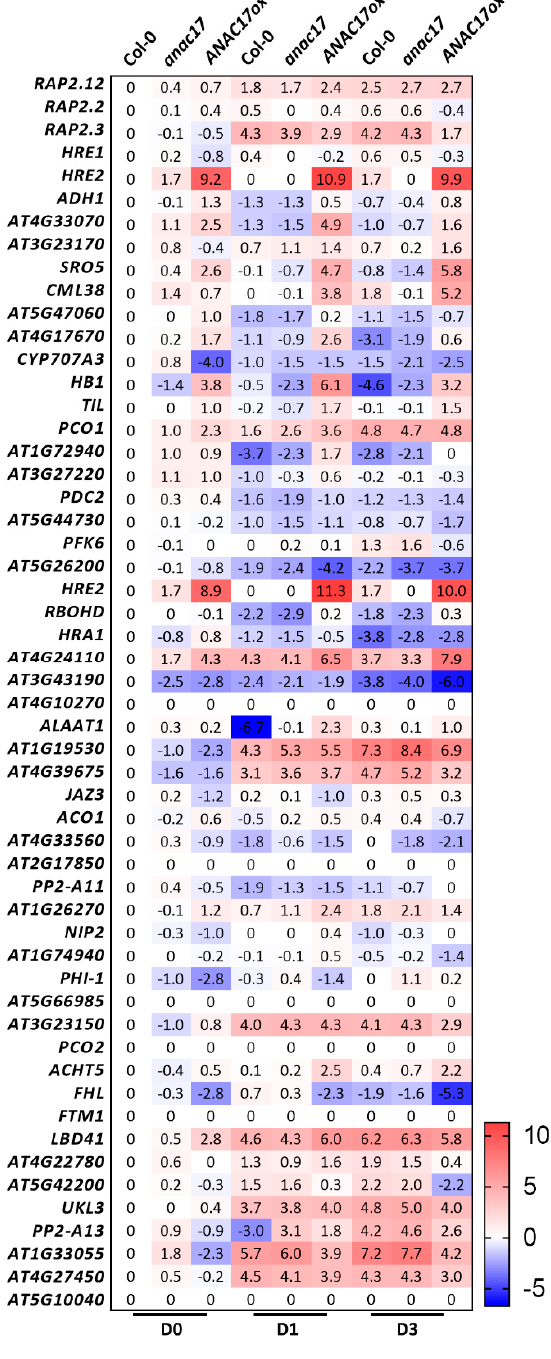
Figure 5. Expression of core-hypoxia genes in ANAC017 lines during senescence in individually darkened leaves. The expression of the previously defined core-hypoxia genes [121] was investigated in publicly available datasets of Col-0, anac017 , and ANAC017 overexpressor lines during senescence in individually darkened leaves [92]. Original datasets used to build this heatmap are available at ArrayExpress under the following accession number: MTAB-8478. D0: control plants, D1: senescence in individually darkened leaves for 1 day, D3: senescence in individually darkened leaves for 3 days. Relative expression is expressed as log 2 fold-change compared to untreated Col-0 plants (D0). For definitions of gene symbols and for a complete description of the gene names that are found in the heatmap, please see Table S3.